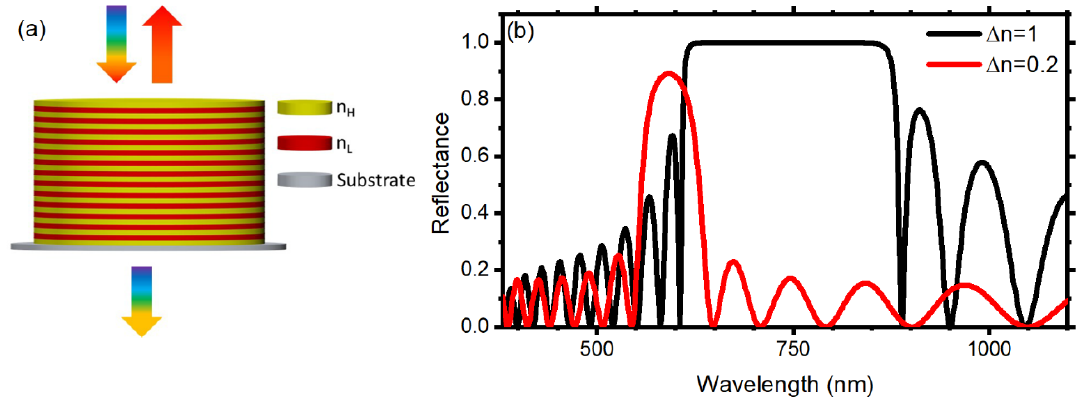
Figure 1. ( a ) Schematic of a distributed Bragg reflector (DBR) structure. ( b ) Typical reflectance spectra for a polymer ( ∆ n = 0.2, red line) and an inorganic ( ∆ n = 1, black line) DBR made of 31 alternated layers of low (110 nm) and high (80 nm) refractive index materials.